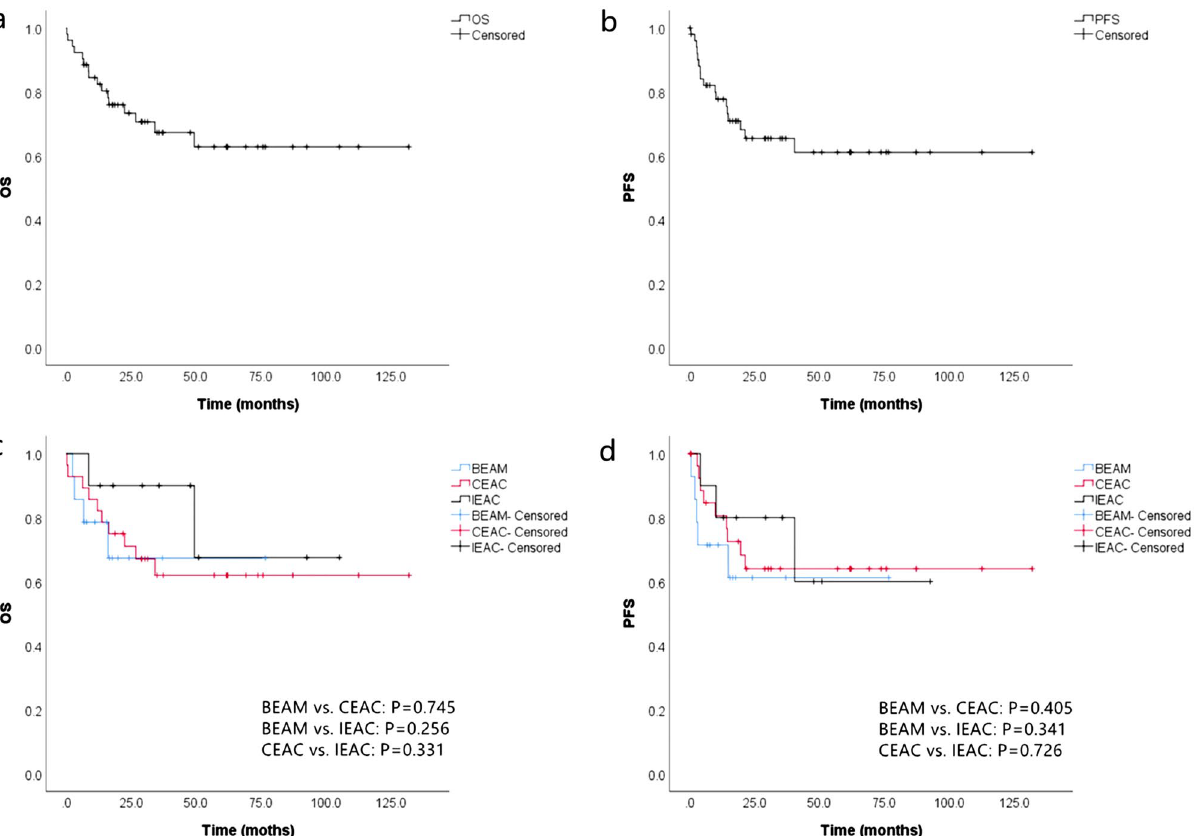
Figure 2. Kaplan–Meier curves of survival. The OS ( a ) and PFS ( b ) curves of 52 patients with PTCL. The OS ( c ) and PFS ( d ) curves of PTCL patients in CEAC (n = 28), BEAM (n = 14) and IEAC (n = 10)